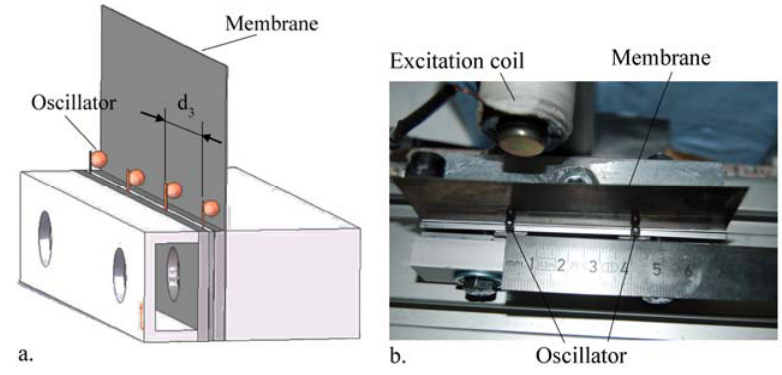
. ( a ) Schematic setup. 3 = 40 mm, 3